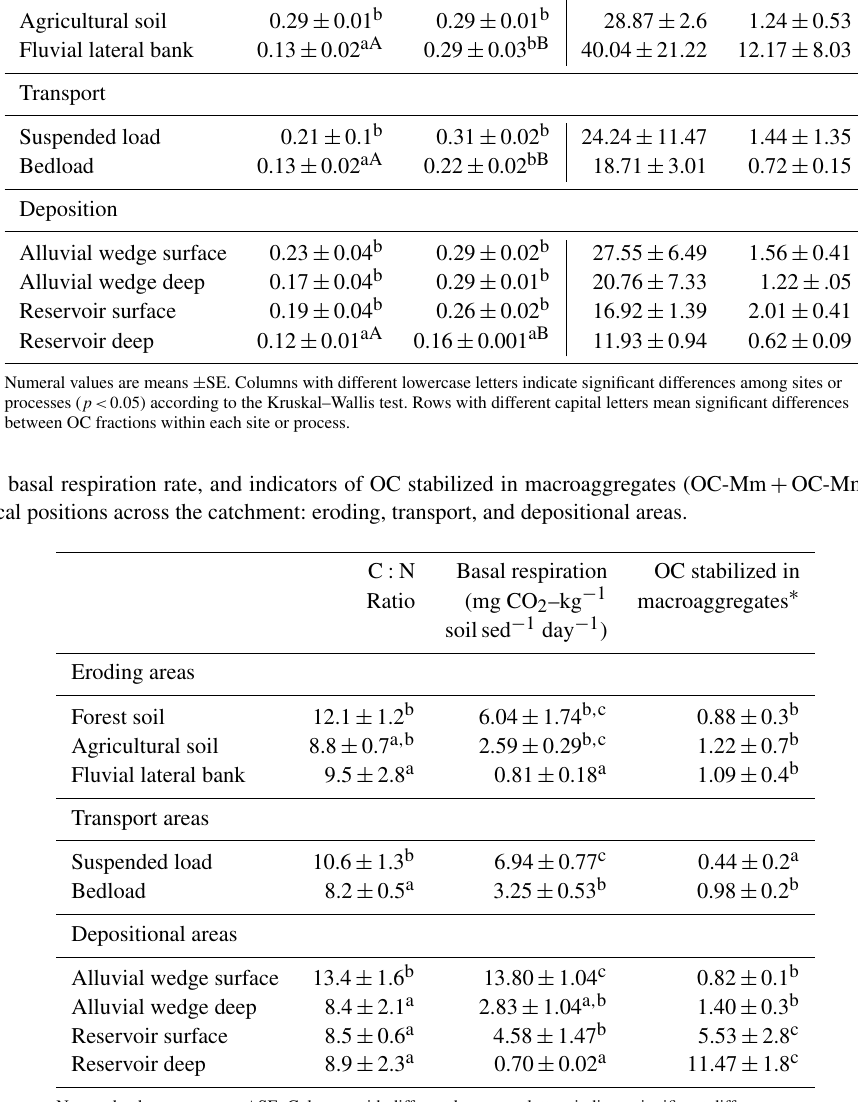
Numeral values are means ± SE. Columns with different lowercase letters indicate significant differences among sites or processes ( p< 0 . 05 ) according to the Kruskal–Wallis test. ∗ The higher the value the more stabilized the OC in